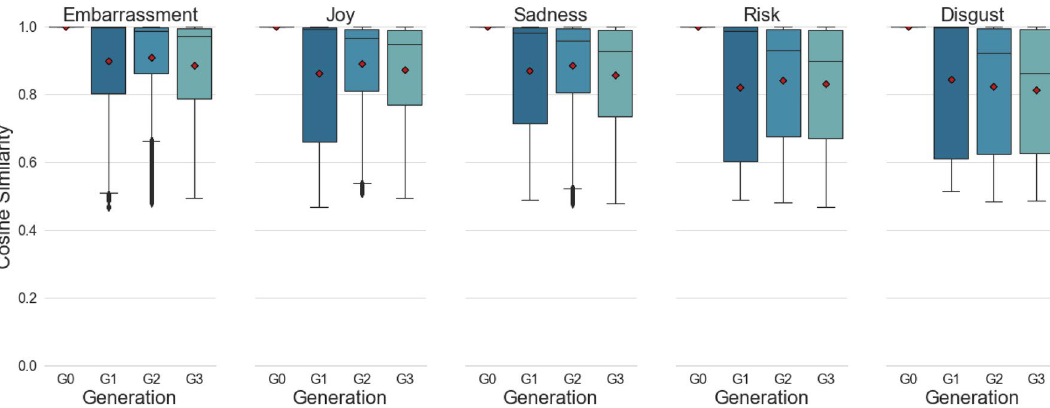
Figure 2. Boxplots of cosine similarity (CS) scores between stories that shared the same story seeds—within each generation. Individual means are represented by red diamonds, and outliers are represented by a black